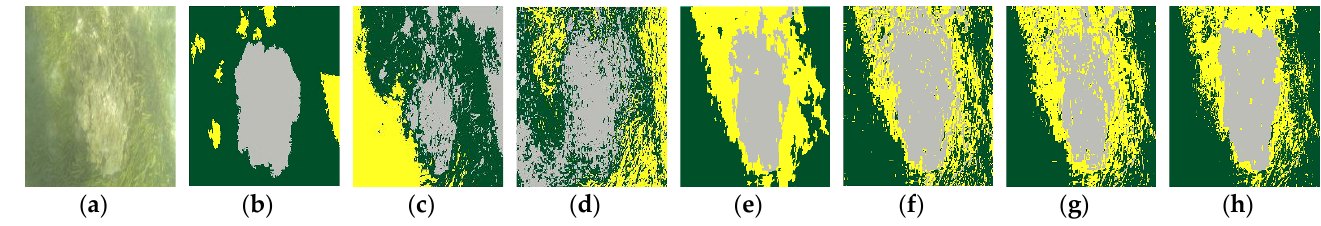
Figure 32. Validation tests of the proposed segmentation algorithms using low illuminated and high contrast seagrass image (16) from Figure 28 as example of three categories: ( a ) original image; ( b ) ground truth image; ( c ) KM result; ( d ) KMAc result; ( e ) FFCr result; ( f ) FRCr result; ( g ) OSCr result; ( h ) KMCr result. Dark green: seagrass, gray: corals, and yellow: sediments.